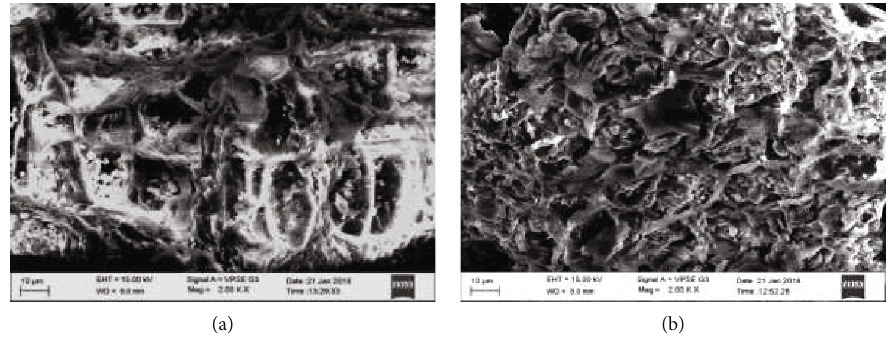
Figure 2: (a) PSS SEM image before CV adsorption and (b) PSS SEM image after CV adsorption.